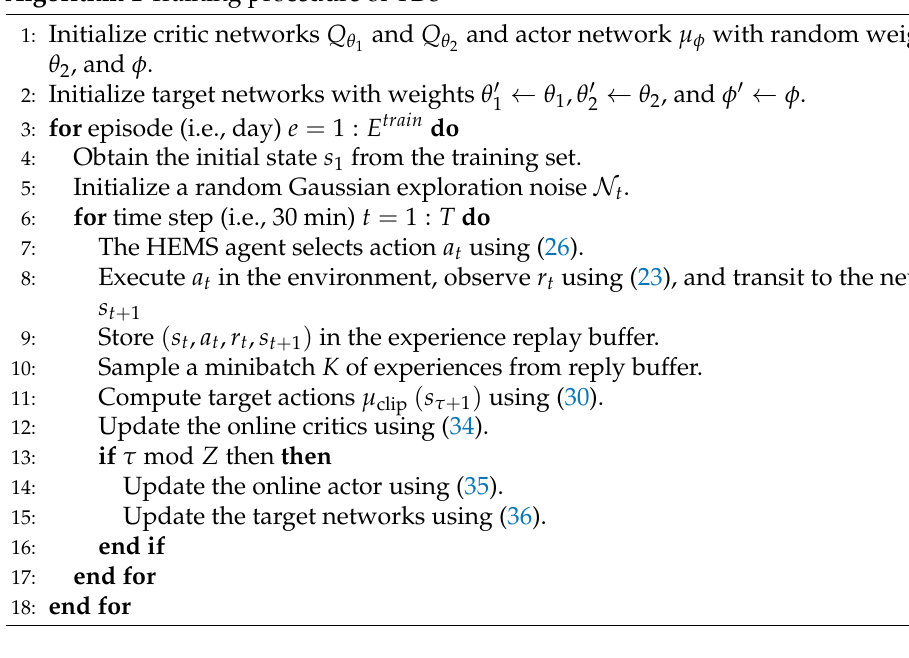
Algorithm 1 Training procedure of TD3